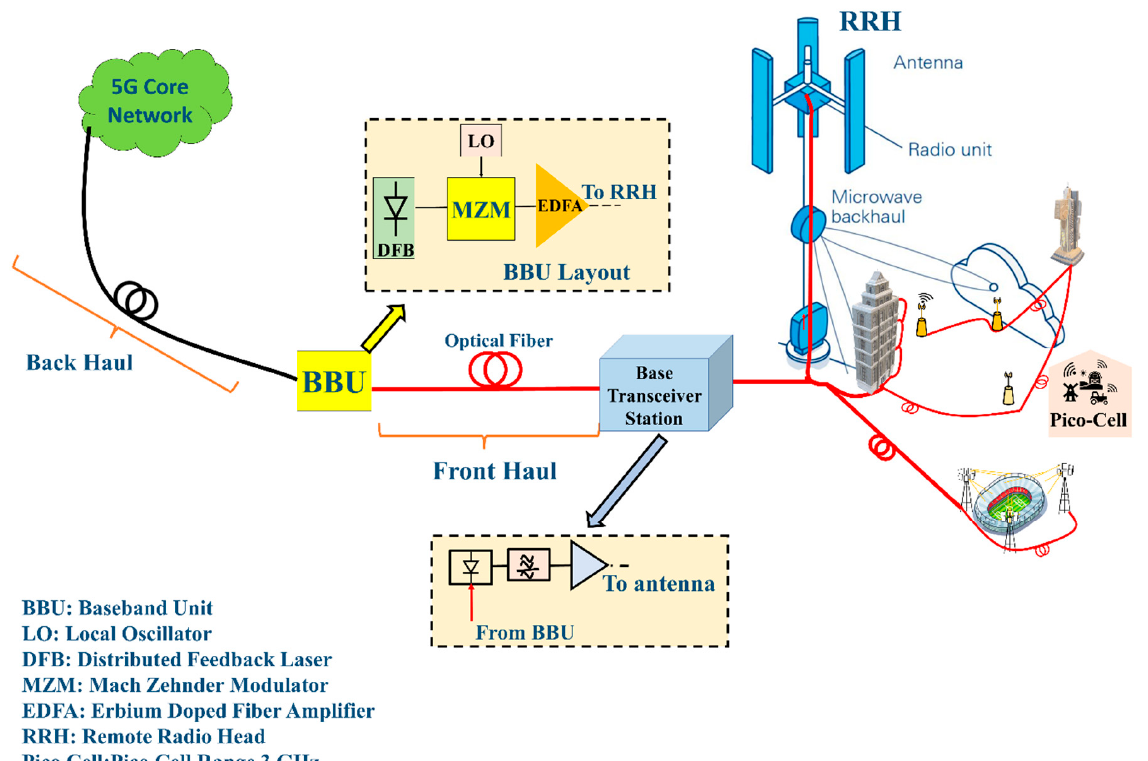
Figure 1. Block diagram explaining backhaul connection to the baseband unit (BBU) connected to optical front haul (OFH), and then its transmission from the transceiver station. The base station further connects it to the remote radio heads (RRHs). Extending the network coverage via fibre and wireless infrastructure is shown w.r.t application scenarios such as picocell, stadiums, buildings, etc.